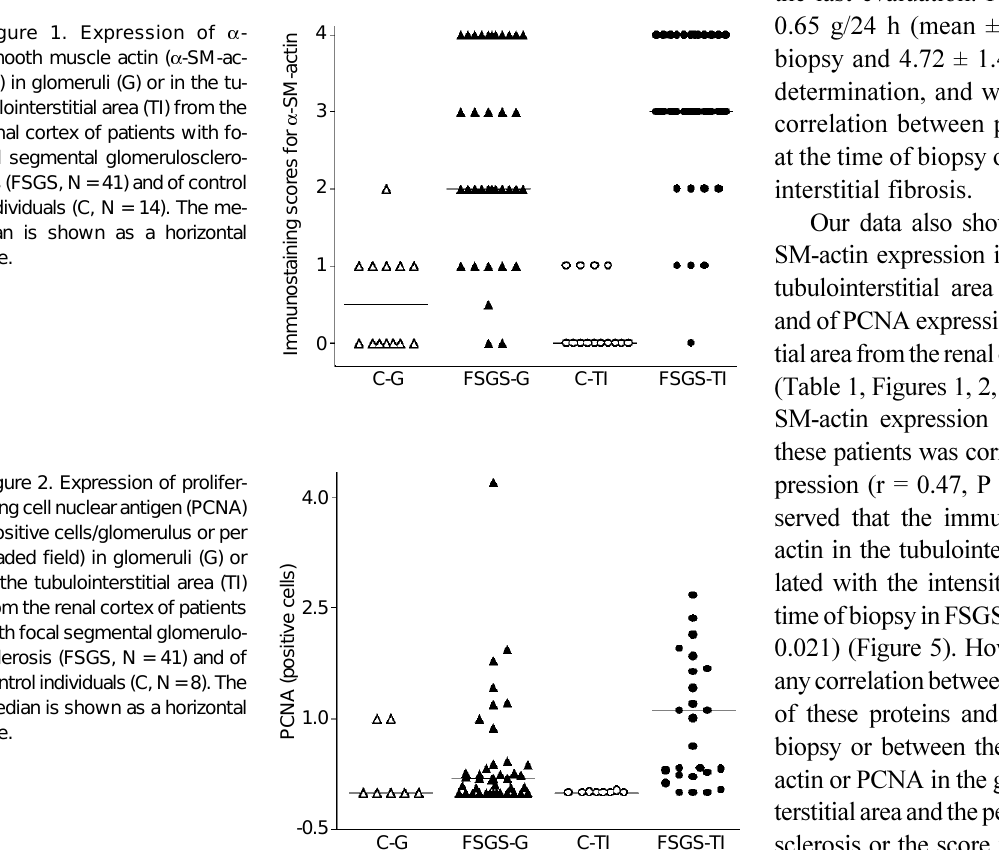
Figure 2. Expression of prolifer- ating cell nuclear antigen (PCNA) (positive cells/glomerulus or per graded field) in glomeruli (G) or in the tubulointerstitial area (TI) from the renal cortex of patients with focal segmental glomerulo- sclerosis (FSGS, N = 41) and of control individuals (C, N = 8). The median is shown as a horizontal